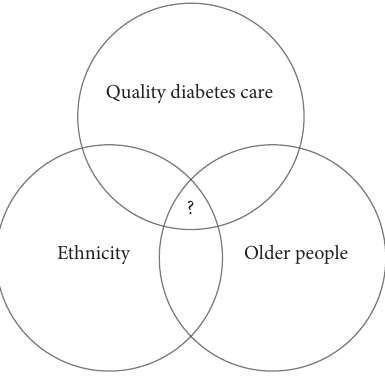
Figure 2: Areas for literature